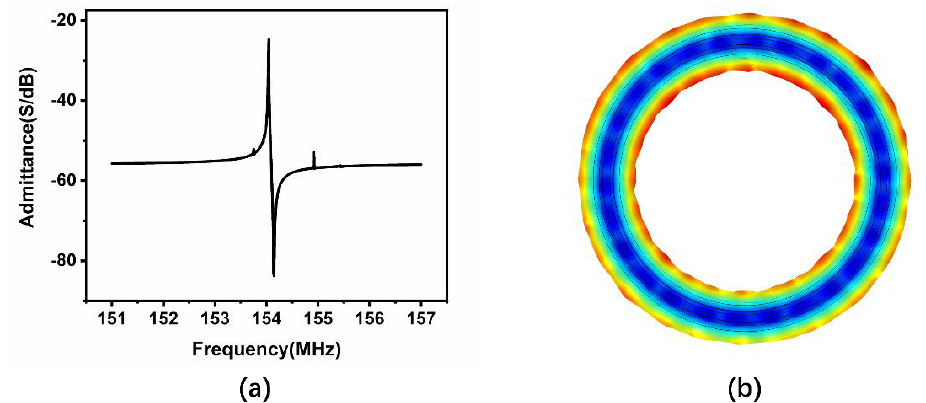
Figure 3. ( a ) Simulation result of the admittance versus frequency of the resonator, ( b ) vibration mode of resonator.